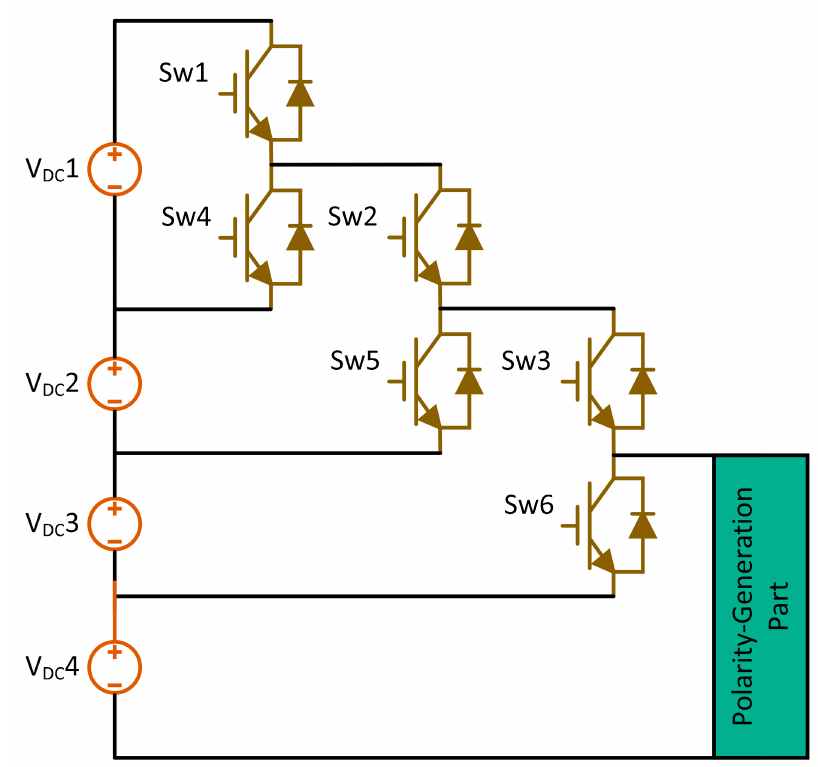
Figure 20. Topology of H-bridge and two-level power modules-based multilevel inverter.